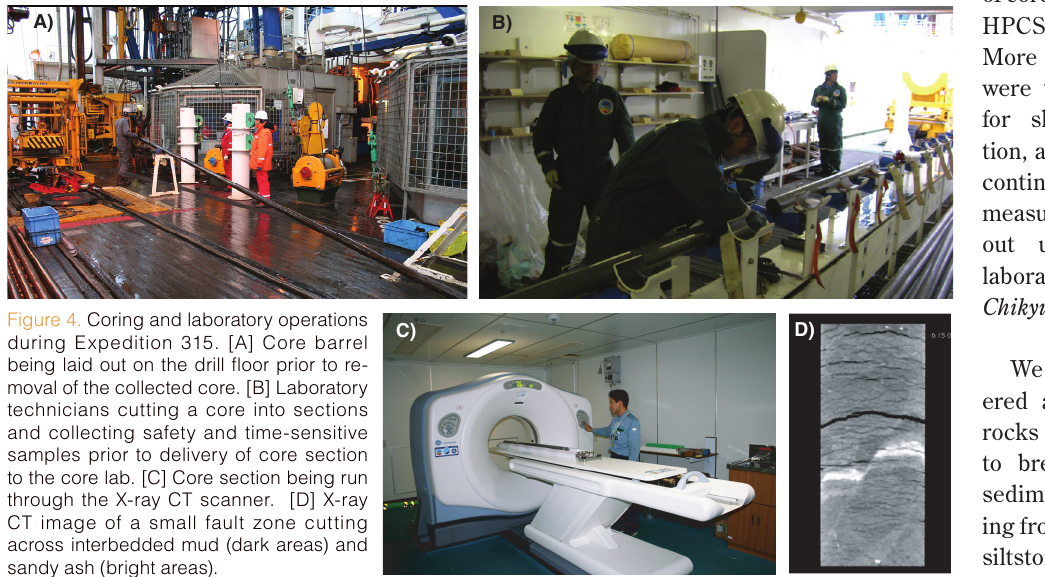
Figure 4. Coring and laboratory operations during Expedition 315. [A] Core barrel being laid out on the drill floor prior to re- moval of the collected core. [B] Laboratory technicians cutting a core into sections and collecting safety and time-sensitive samples prior to delivery of core section to the core lab. [C] Core section being run through the X-ray CT scanner. [D] X-ray CT image of a small fault zone cutting across interbedded mud (dark areas) and sandy ash (bright